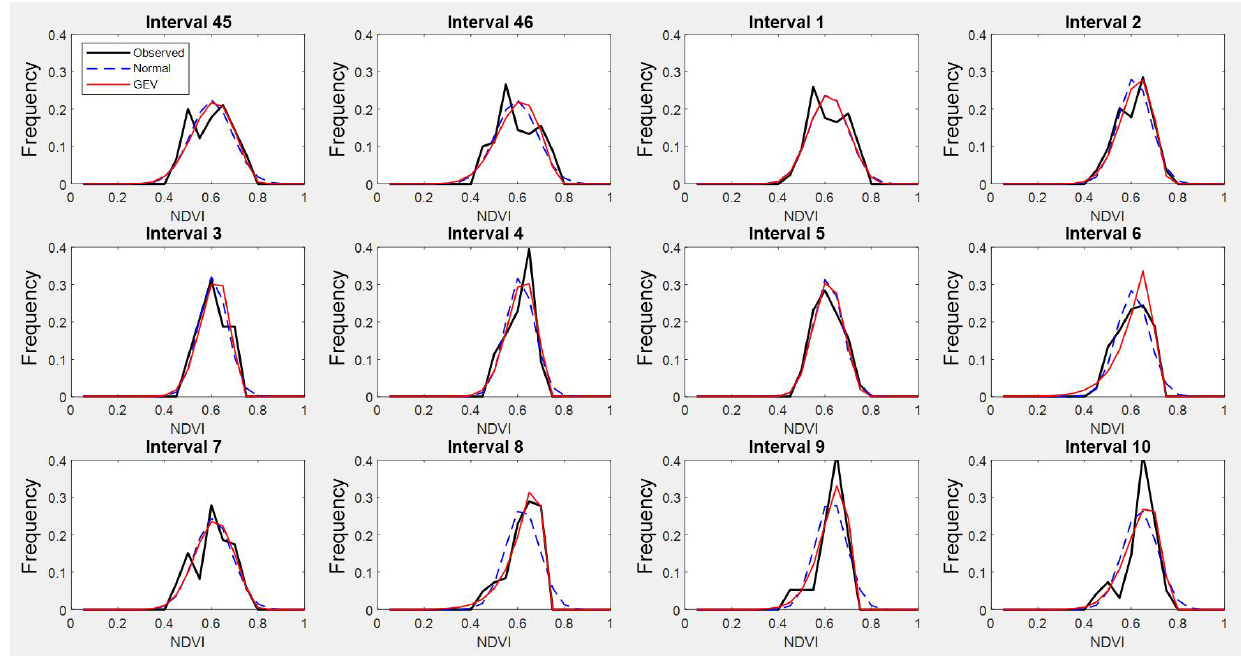
Figure A1. Observed NDVI, GEV and normal probability density functions from interval 45 to interval 10 (from 19 December to 21 March) representing